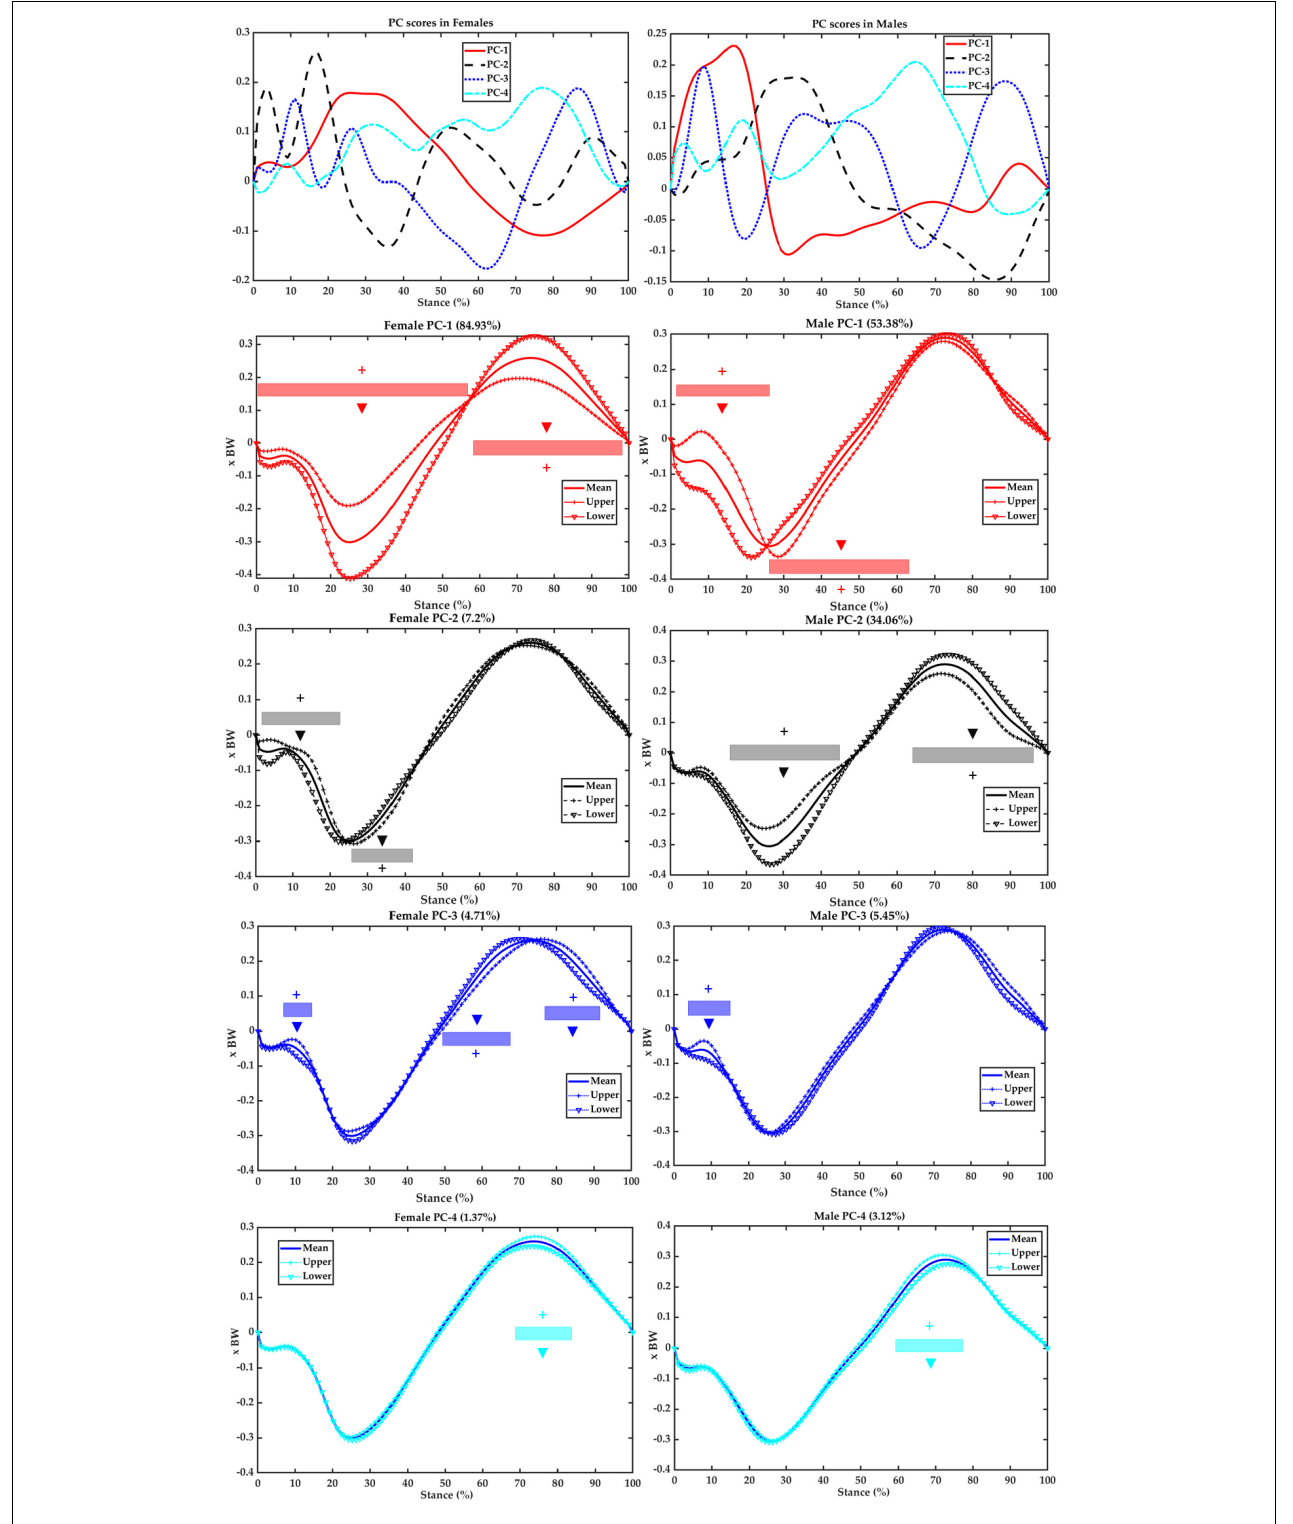
FIGURE 5 | Scores of the first four PCs (first row) and variances of PC1 (second row in red), PC2 (third row in black), PC3 (fourth row in blue), and PC4 (fifth row in cyan) against the mean ant–post GRF of the female (left) and male (right) runners. Upper (plus SD) limit (with symbol “+”) and lower (minus SD) limit (with symbol “ (cid:116) ”) highlight the contribution of plus/minus of the scores and coefficients for this PC.